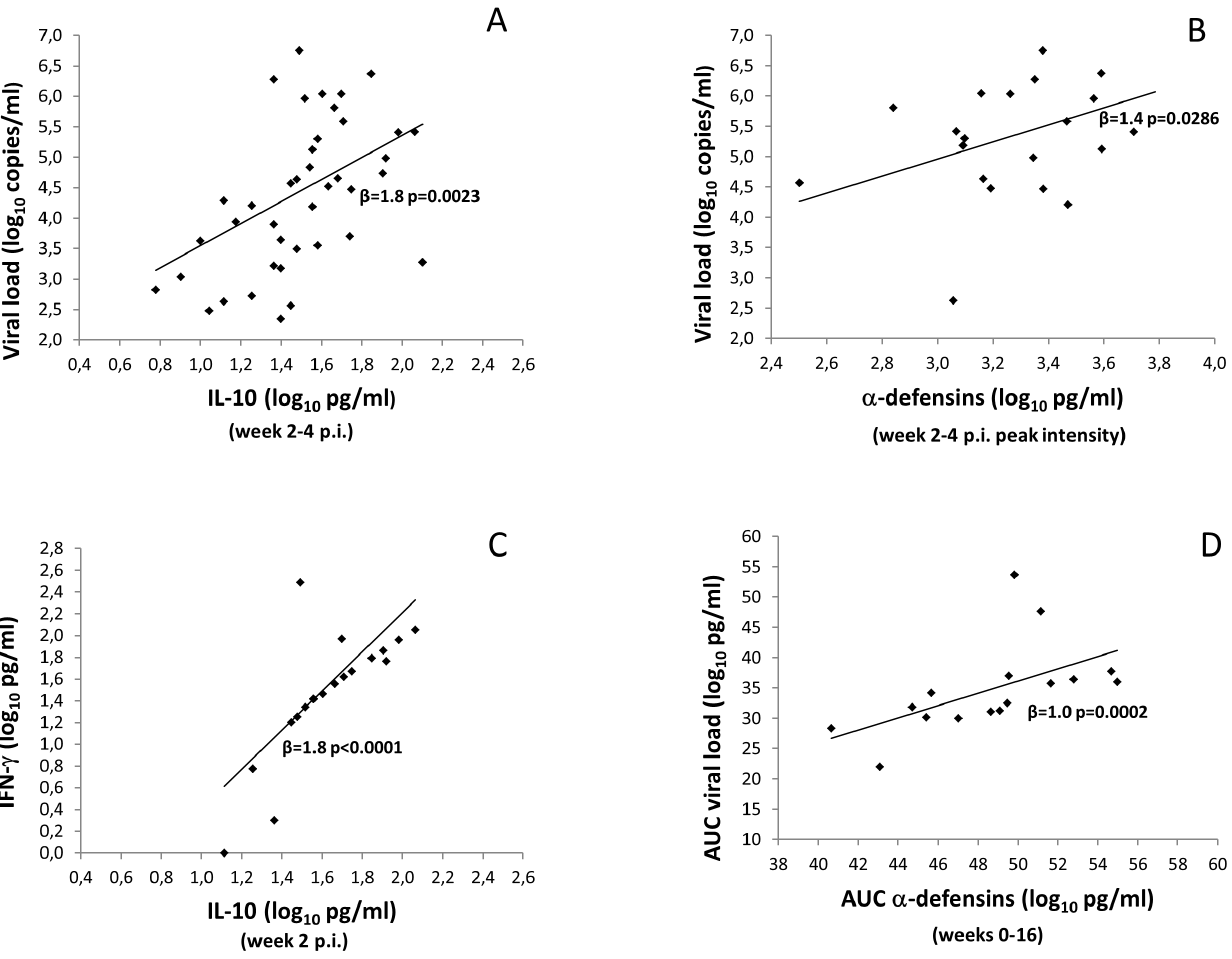
Figure 3. Regression analyses between immunological and virological parameters in infected monkeys during the acute phase of SHIV SF162P4cy infection. A significant relationship was detected between: A) IL-10 production and plasma viral load (p=0.0023); B) a -defensins production and viral RNA (p=0.0286); C) IFN c and IL-10 production (p , 0.0001). D) AUC: significant relationship between viral load and a -defensins (p=0.0002).